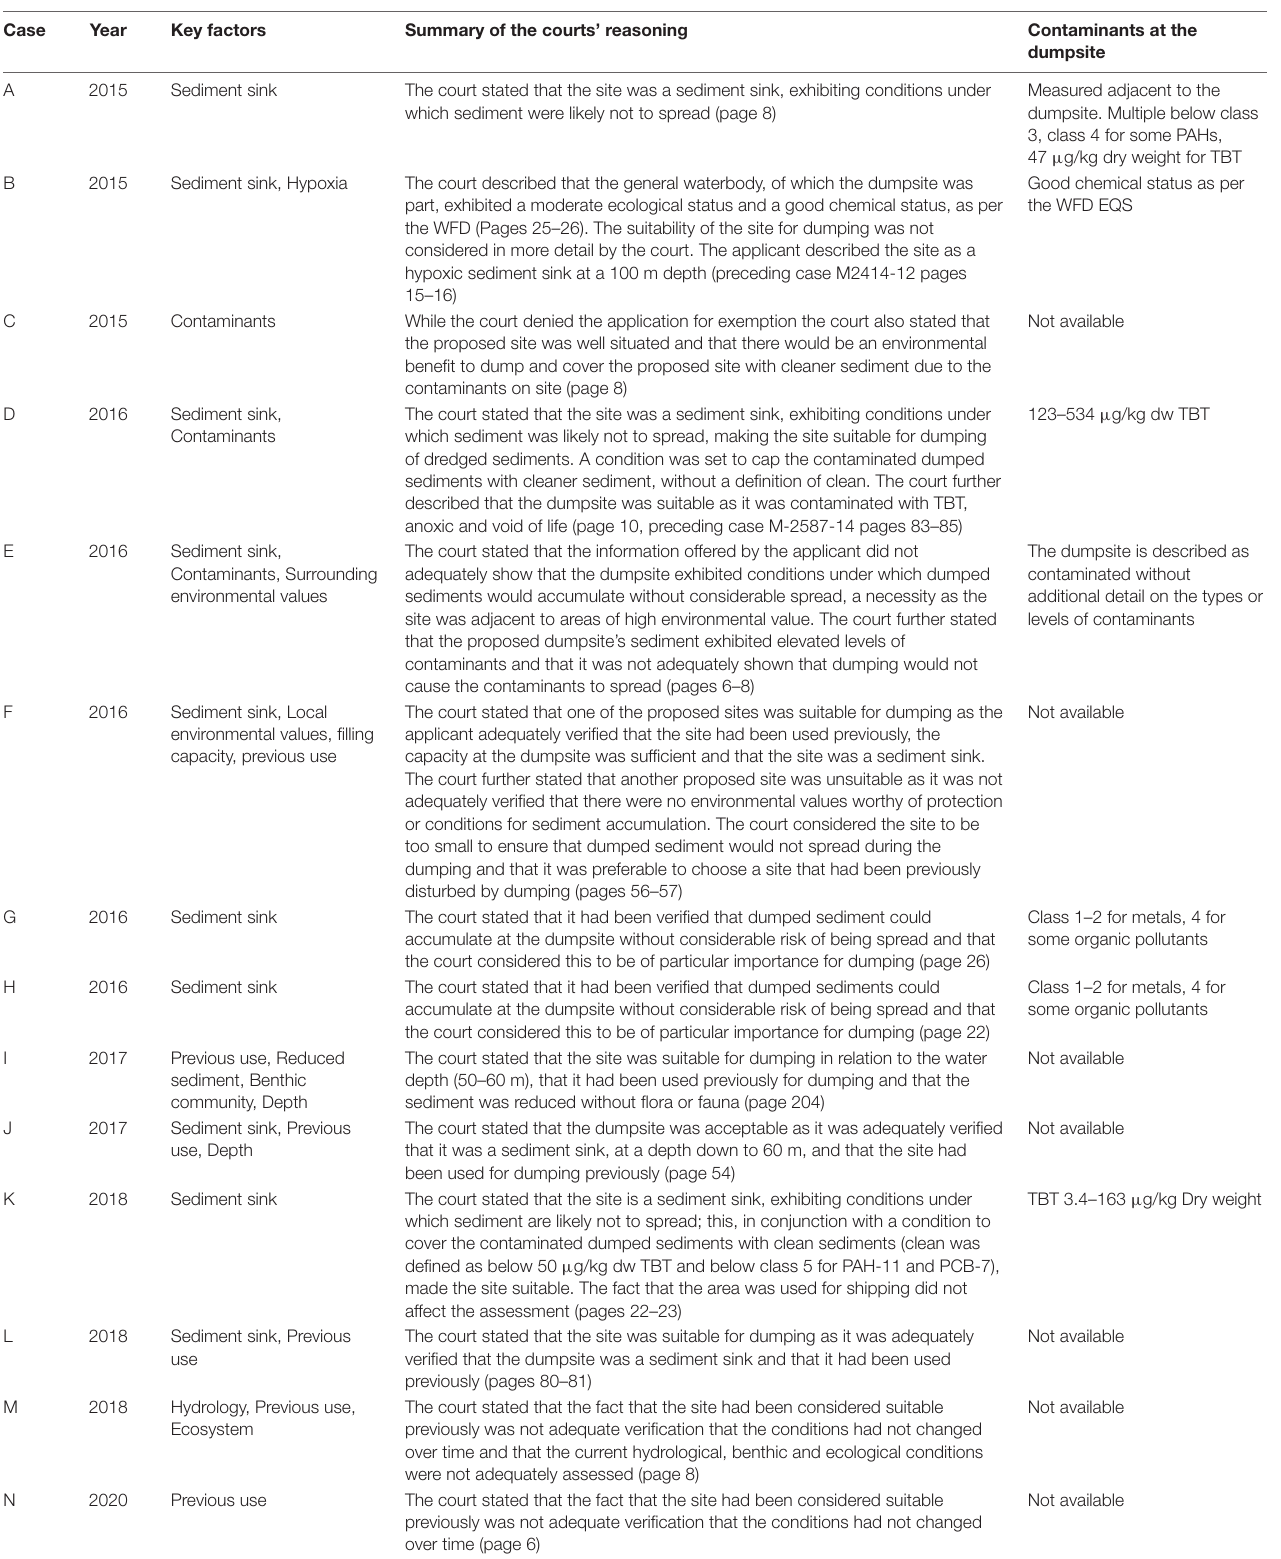
TABLE 4 | Key factors considered by the courts when determining the suitability of proposed dumpsites, with summaries of the reasoning by the courts and contaminant levels at the dumpsite previous to the planned